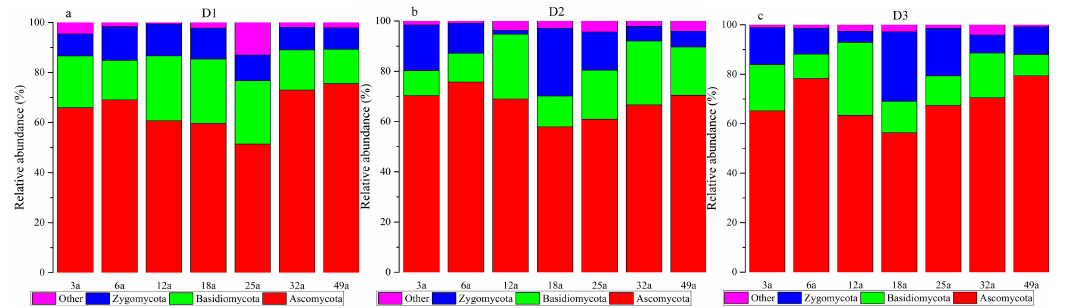
Figure 5. The compositions of fungal community at the phylum level in different stand age samples. ( a ) Fungal community at the phylum level in D1, ( b ) fungal community at the phylum level in D2, ( c ) fungal community at the phylum level in D3.